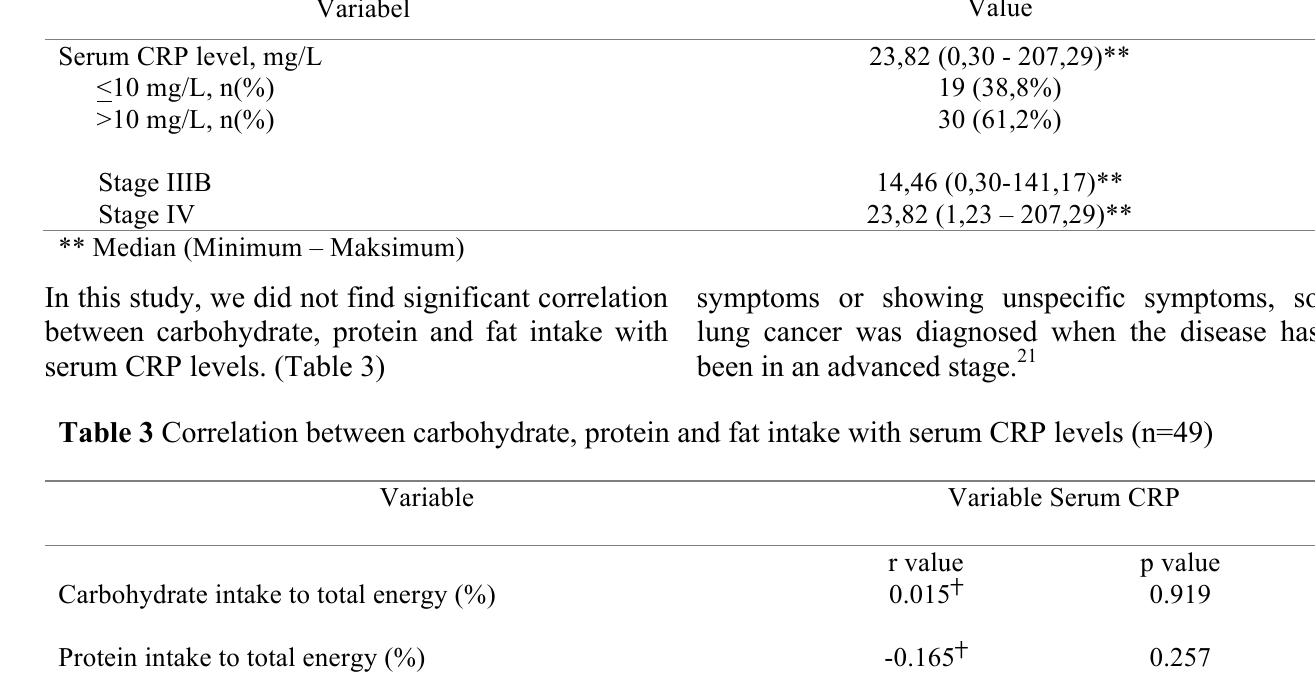
Table 2 Serum CRP level